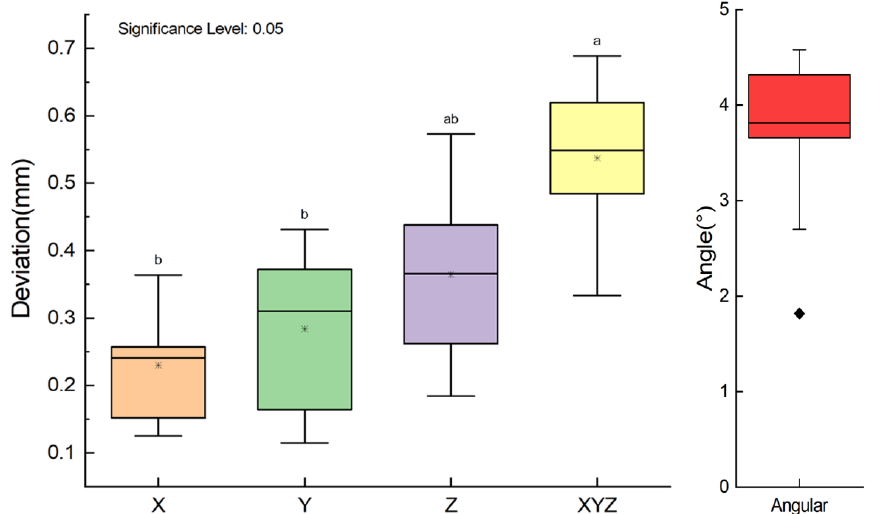
Figure 5. Box plot of deviation on axes (For all variables with the same letter, the difference is not statistically significant ( p > 0.05). Different letters between groups represents significantly different ( p < 0.05)).